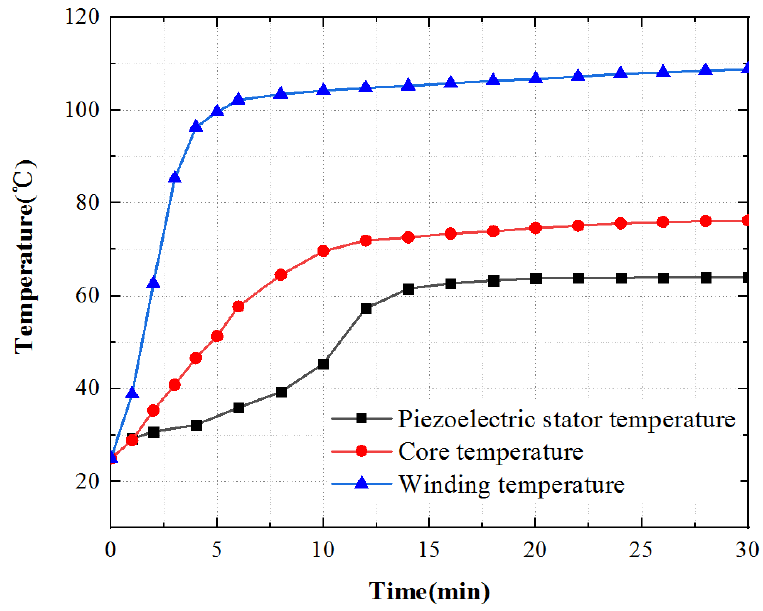
Figure 22. Temperature time characteristic curve. Finally, according to the theoretical analysis, the calculation results are contrasted with the experimental measurement data, as shown in Figure 23.